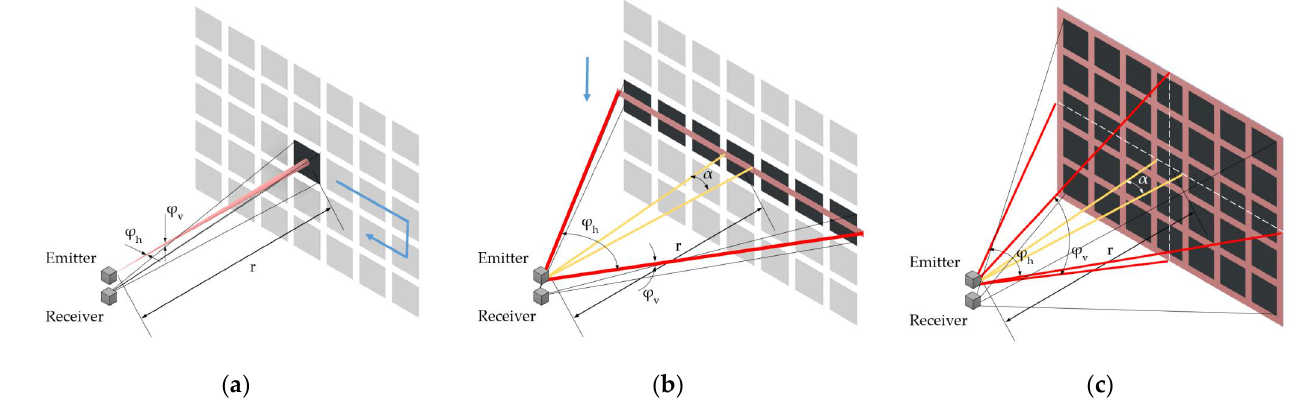
Figure 1. Radiation patterns of LiDAR systems according to [22]: ( a ) spot irradiation with collimated beam; ( b ) horizontal blade irradiation; and ( c ) flash irradiation of the entire FOV.